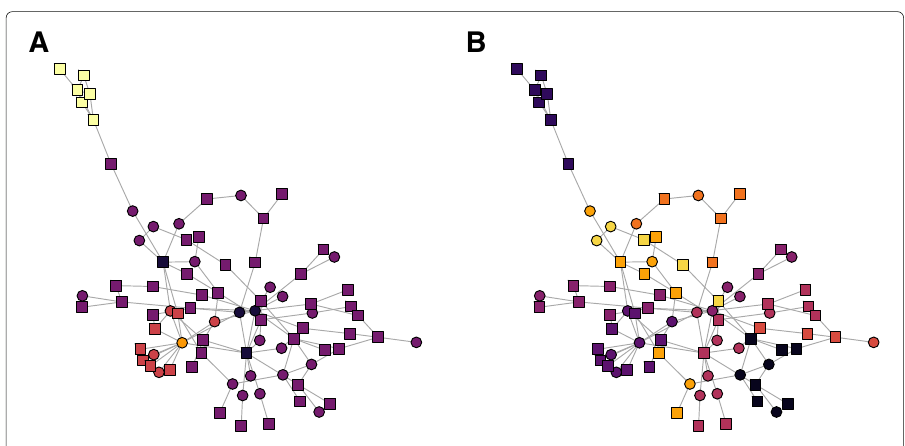
Fig. 9 Protein interaction network. We visualize the 82 node protein interaction network under the classic stochastic block model ( a .) and the attributed stochastic block model ( b .) In both networks, nodes are colored by their community assignment and the node shape indicates whether the modification status increased (square) or decreased. a . Nodes colored according to the community partition under the stochastic block model. Nodes are assigned to one of five communities. b . Nodes are colored to the community partition under the attributed SBM. Nodes are assigned to one of nine